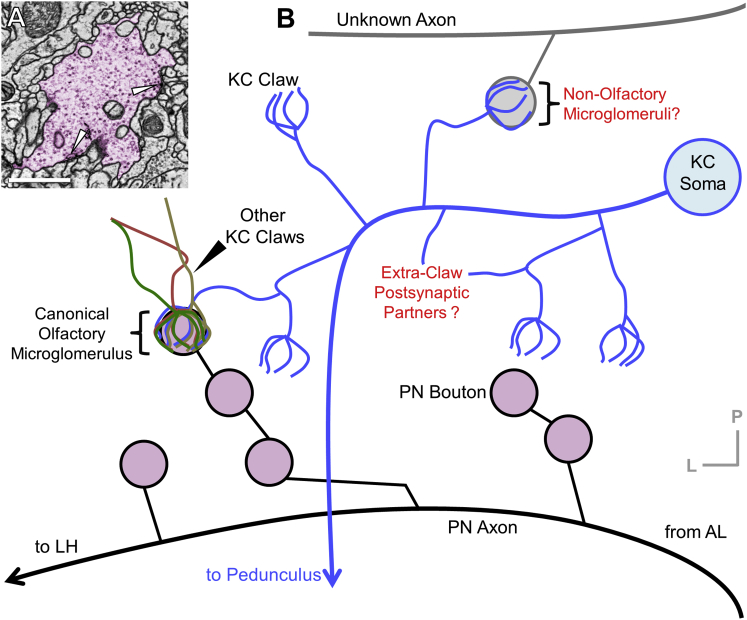
Neuronal Architecture of the MB Calyx, Related to Figure 1(A) Micrograph of a microglomerulus in MB calyx. A canonical olfactory PN bouton (pink) is presynaptic to several fine KC dendrites, forming a synaptic complex referred to as a microglomerulus (Yasuyama et al., 2002). Arrows: presynaptic release sites.(B) Schematic of microglomerular inputs to KCs in MB calyx of Drosophila. The PN axons extend collaterals from the mALT into the calyx and provide bouton inputs to KCs. The Drosophila MB has ∼2,000 KCs on each side of the brain (Aso et al., 2014). Each KC projects a highly variable dendritic arbor into the calyx, which terminates in elaborations known as claws. Claws from many KCs wrap individual PN boutons to form each microglomerulus (Yasuyama et al., 2002), and each KC receives input from multiple PNs of diverse types across its claws (Caron et al., 2013, Gruntman and Turner, 2013). The complete composition of cell types that provide driving inputs via microglomeruli in the calyx is unknown. KCs have been shown to form presynaptic release sites in the calyx mostly outside of claws (Butcher et al., 2012, Christiansen et al., 2011), but the complete set of postsynaptic partners is unknown.Scale Bar: 1 μm in (A).